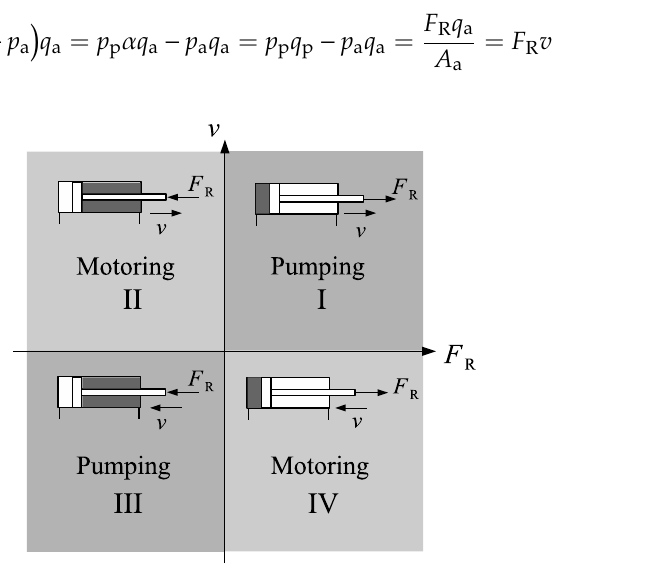
Figure 10. Operational quadrants.